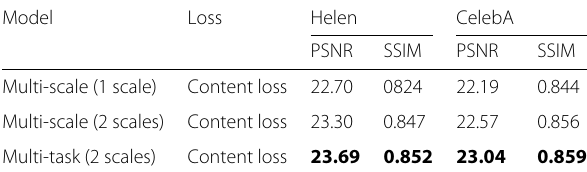
Table 1 Quantitative evaluation for multi-task framework Model